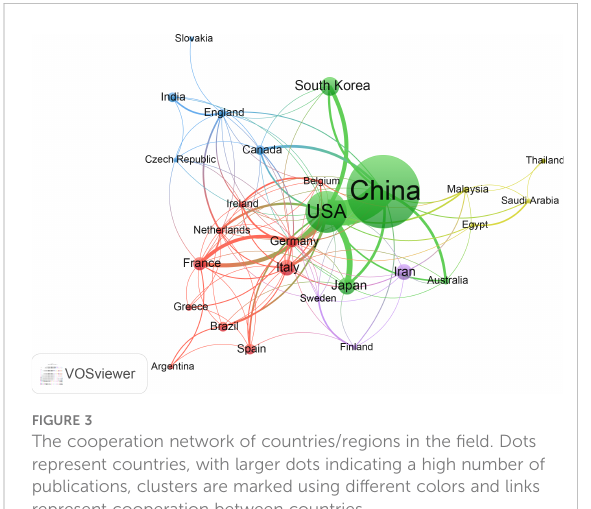
FIGURE 4 The cooperation network of institutions in the fi eld. Dots represent institutions, with larger dots indicating a high number of publications, clusters are marked using different colors and links represent cooperation between